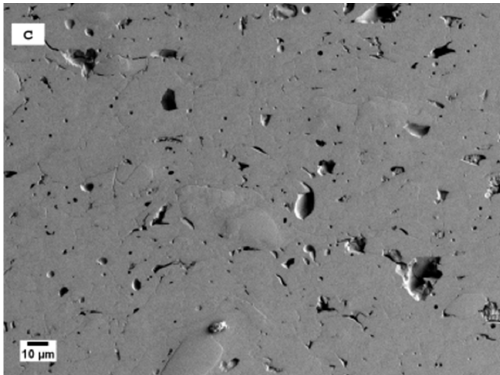
Figure 4. Cross-sectional SEM micrographs of as-sprayed alumina coatings indicating the coating porosity and cracks deposited with: ( a ) fine powder, ( b ) medium powder, and ( c ) coarse powder. In general, the total porosity levels for all coatings increases when increasing the feedstock powder particle size is increased. This increase is mainly due to the simultaneous increase of both the number and size of large pores, whereas fine and medium pores decrease.